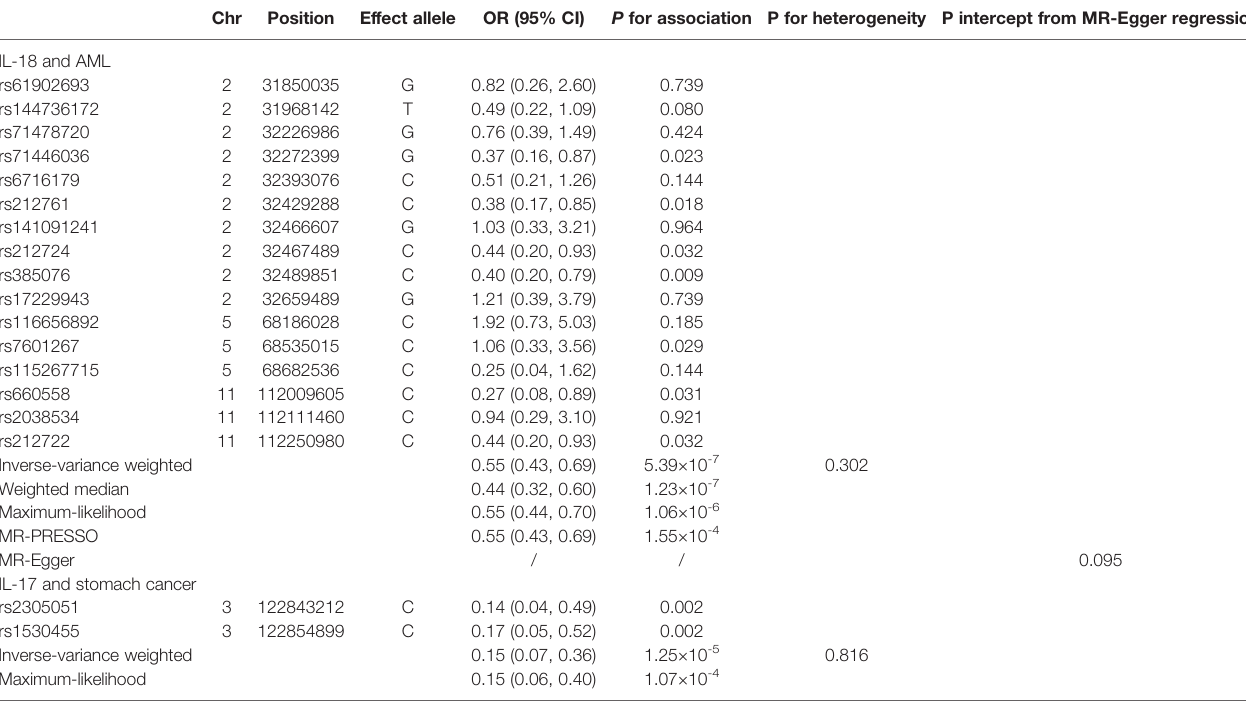
TABLE 1 | MR effect estimates for associations of circulating IL-18 with the risk of AML and IL-17 with stomach cancer. Chr Position Effect allele OR (95% CI) P for association P for heterogeneity P intercept from MR-Egger